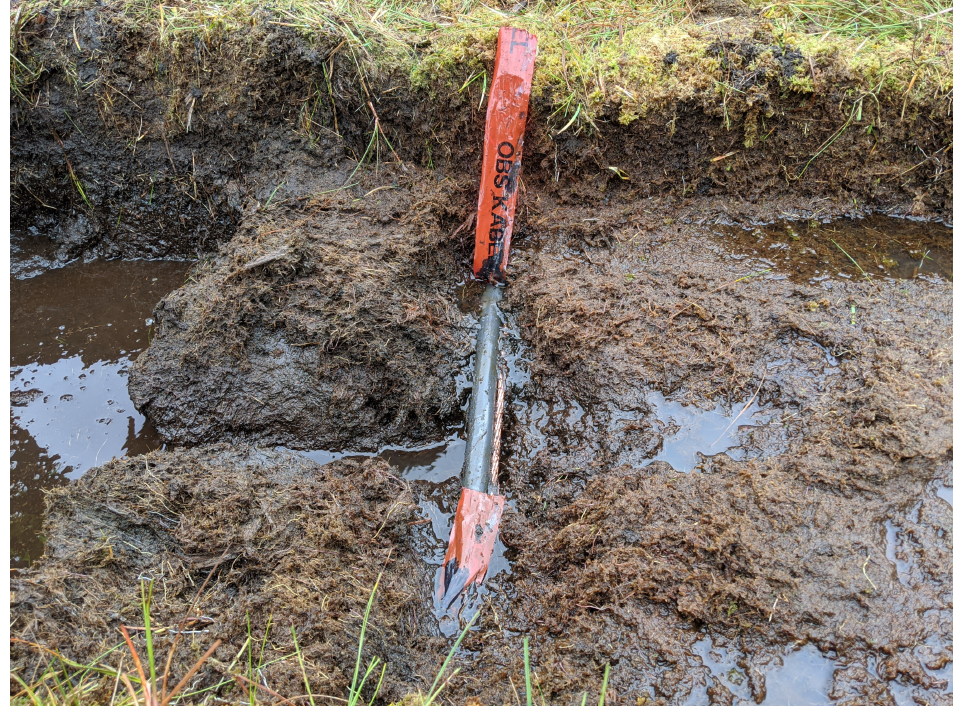
Figure 8. The excavation in Field B confirming the presence of a modern cable that had been detected with GPR. Image: Claes Olof Johan Uhnér,